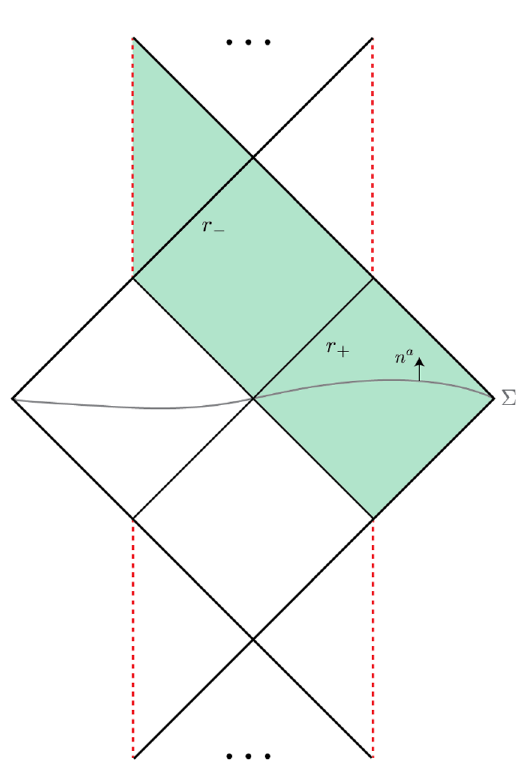
Figure 1 . Penrose diagram of the maximally extended Reissner-Nordström geometry. Its timelike singularities are red dotted lines, the inner and outer horizon given by r ± , and the gray surface Σ is a Cauchy slice with normal vector n a . In this paper we restrict to the green shaded region. Classically, the Penrose diagram extends indefinitely to the past and